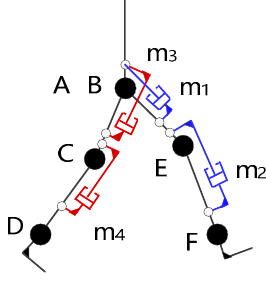
Figure 7. Driving scheme.